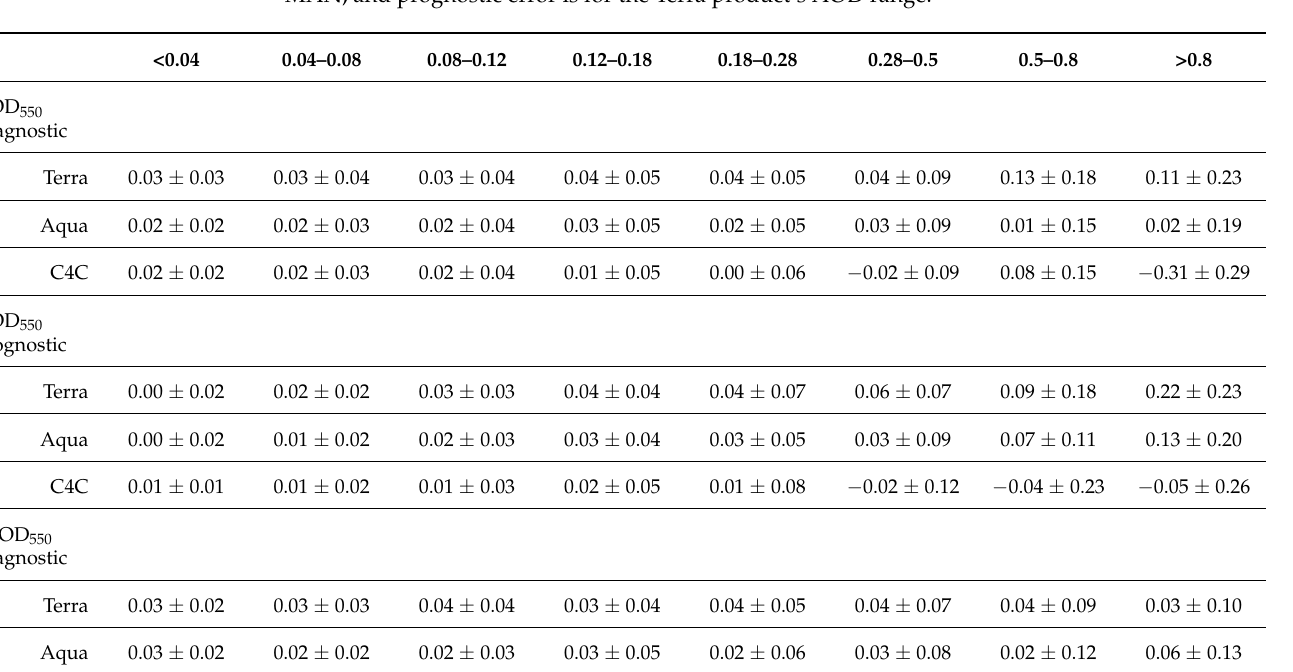
Table 1. Diagnostic and prognostic mean bias/root mean square error (RMSE) against MAN for total AOD (AOD 550 ), fine mode AOD (FAOD 550 ), and coarse mode (CAOD 550 ) for all data points. Mean bias is defined as the average of S i –O i , where S is the retrieved/predicted variable and O is taken as MAN. Errors are aggregated by the AOD range, where the diagnostic error is aggregated against MAN data used as the observation. Prognostic error is taken as the statistics associated with the AOD range taken from that product. For example, Terra MODIS diagnostic error is the AOD range is from MAN, and prognostic error is for the Terra product’s AOD